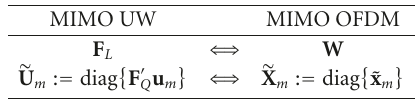
Figure 4: Indicator function and approximate logarithmic func- tions. The dashed lines show the indicator function and the solid lines show the approximations for t = 0 . 5,1,2. The best approxi- mation is given by t = 2 [22]. Table 1: Di ff erences in MSE expressions for MIMO UW and MIMO OFDM channel